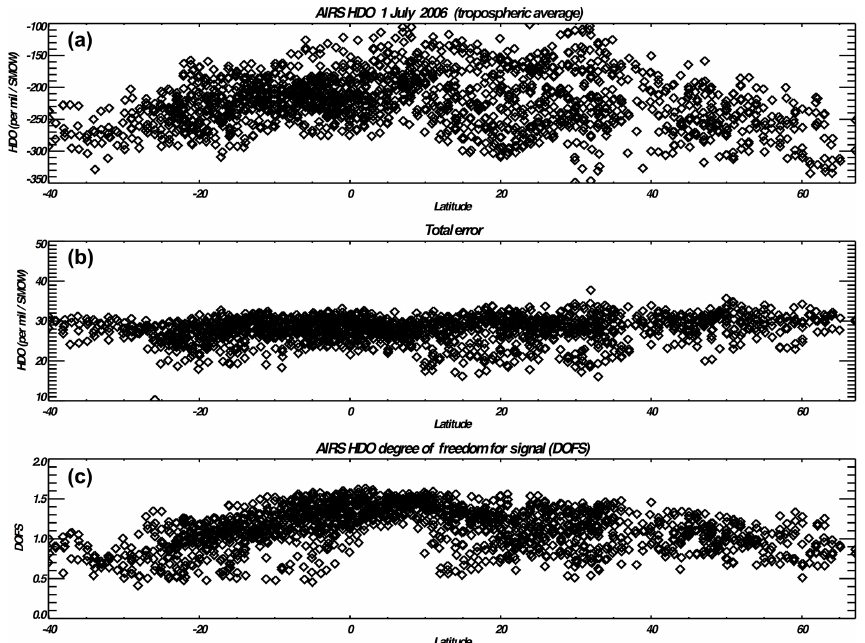
Figure 3. (a) The mean tropospheric deuterium content (in “per mil” or units of parts per thousand relative to the deuterium content of the ocean or SMOW) for 1 June 2006 as inferred from AIRS radiance measurements. (b) The total error for the measurements in (a) (also in units of per mil relative to SMOW). (c) The DOFS for the retrieval.